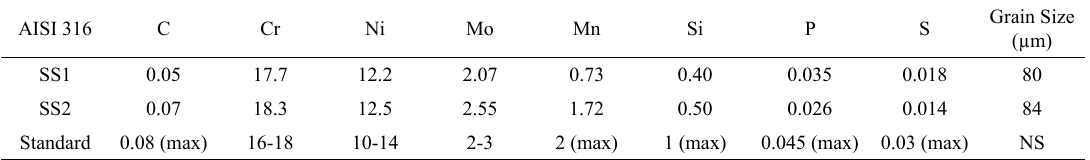
Table 1. Chemical composition (wt%) and average grain size of the investigated 316 steels. AISI 316